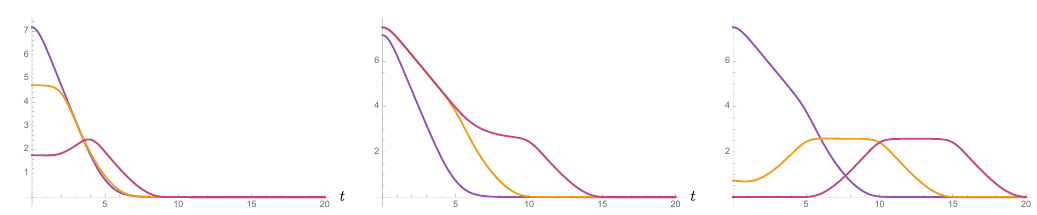
Figure 6 . The time dependent piece of the second operator R(cid:19)enyi negativity (or equivalently the bipartite second R(cid:19)enyi operator mutual information) is shown for the compact boson (3.25). As usual, we have (left) OLN with l 1 = l 2 = 5, and the distance between starting positions varying as f 0 ; 2 ; 4 g . (center) l 1 = 5, l 2 = f 5 ; 10 ; 15 g with both intervals starting at the same position. (right) l 1 = 5, l 2 = 10, fully overlapped (purple), adjacent (yellow), and separated by 5 (magenta). We use a compacti(cid:12)cation radius of (cid:17) = 2 and cuto(cid:11) (cid:12) = 4. The quasi-particle picture is certainly present though less pronounced than for the free